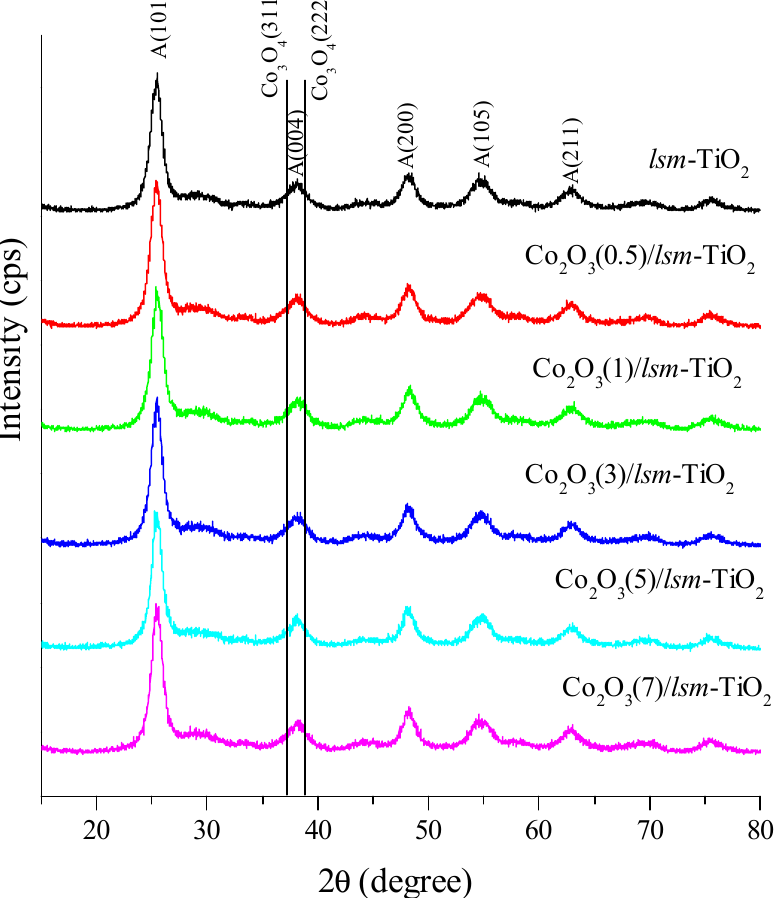
Figure2. XRDpatternsof lsm -TiO 2 hybridsmodifiedwithdi ff Figure 2. XRD patterns of lsm -TiO 2 hybrids modified with different amount of cobalt oxide nanoparticles.